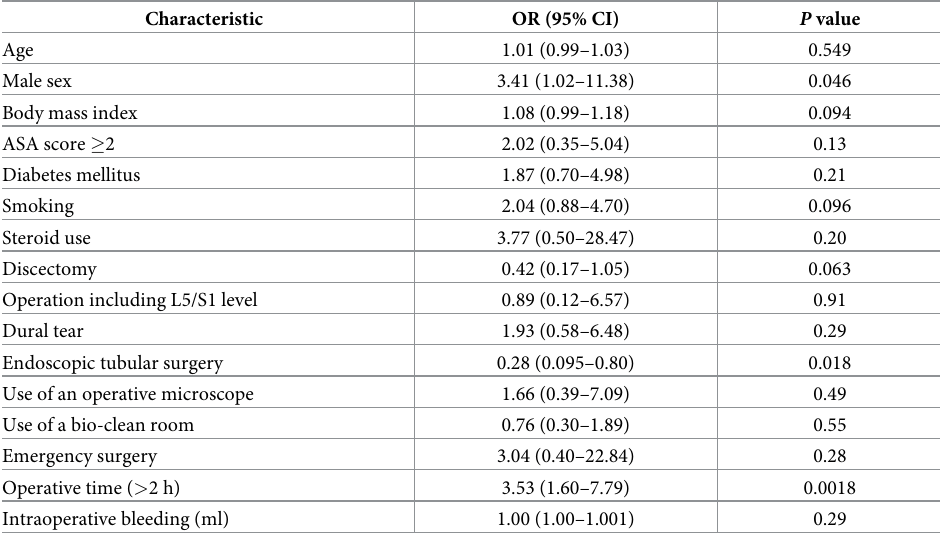
Table 2. Univariate logistic regression analysis for SSI after lumbar laminectomy and/or herniotomy. Characteristic